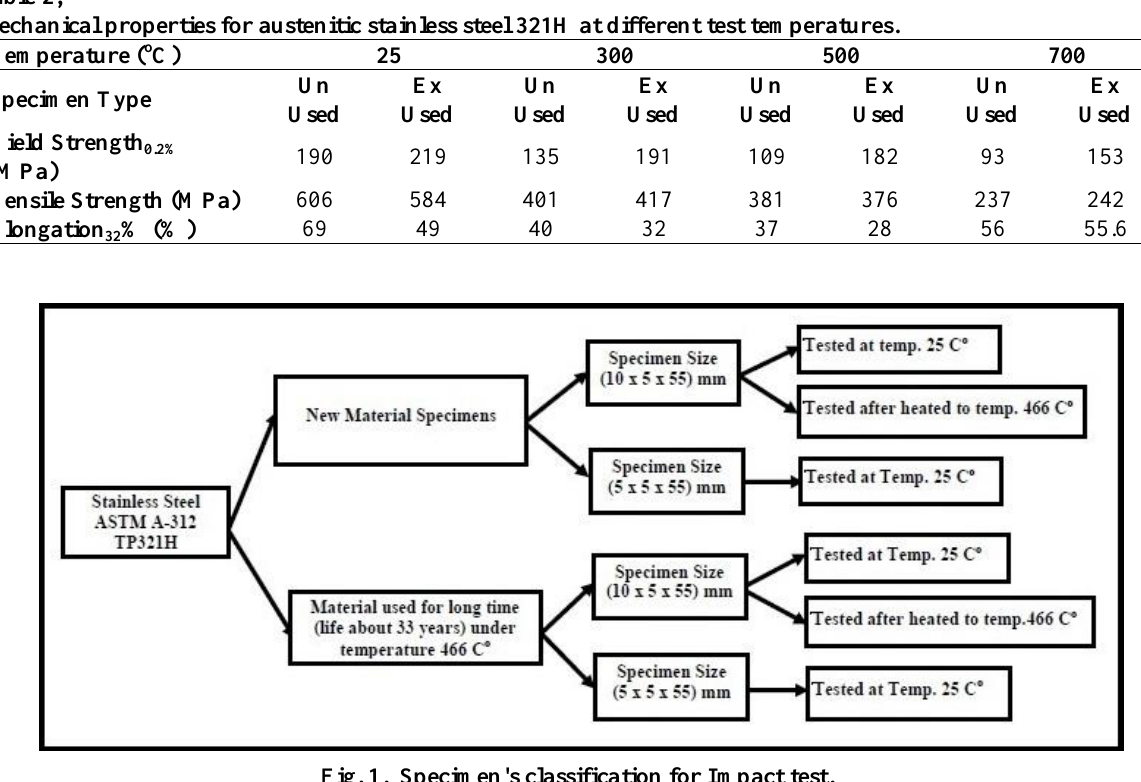
Fig. 1. Specimen's classification for Impact test.